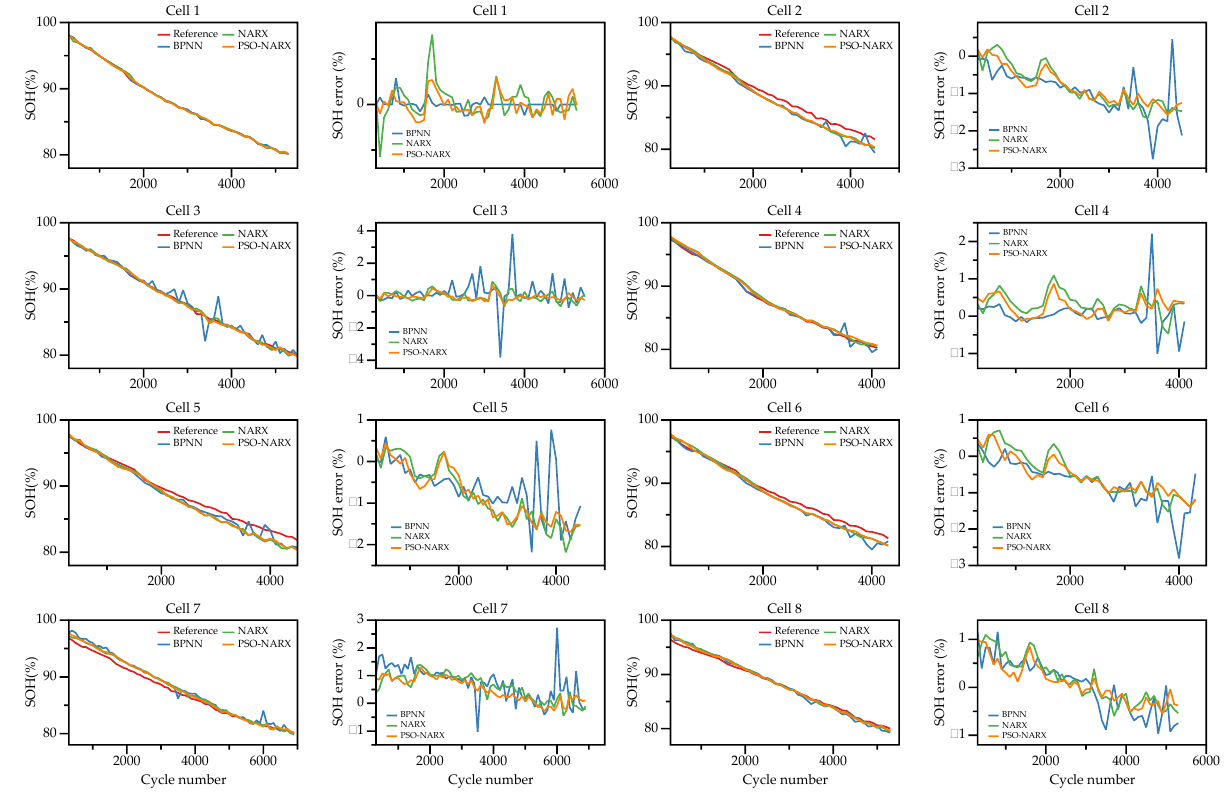
Figure 13. SOH estimation results of different algorithms.